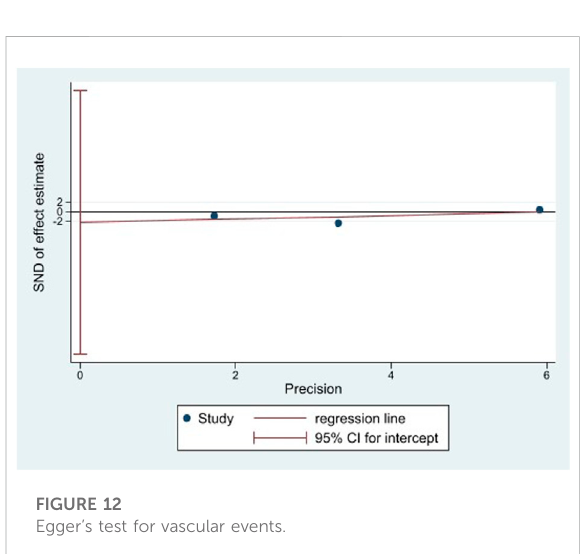
FIGURE 12 Egger ’ s test for vascular